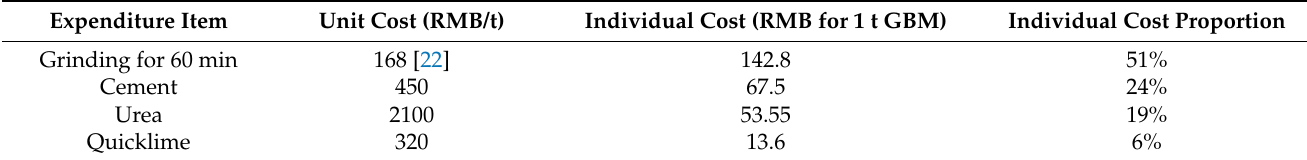
Table 4. Economic cost involved for G60U3-based GBM-B2 with 5%